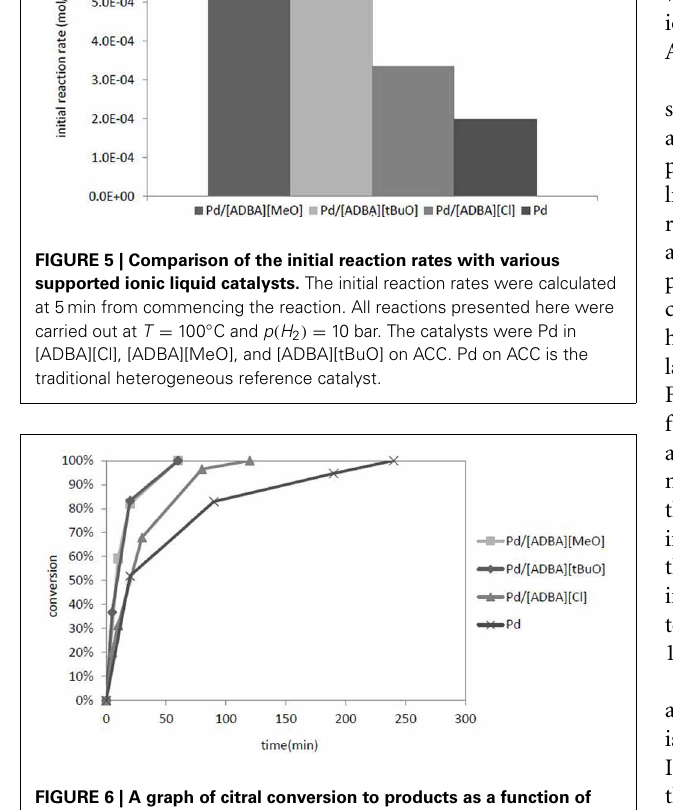
containing [ADBA][Cl] were chosen as reference catalysts. The reaction conditions were T = 100 ◦ C, p ( H 2 ) = 10 bar. Other products are compounds from cracking and dehydration of citral and its hydrogenation